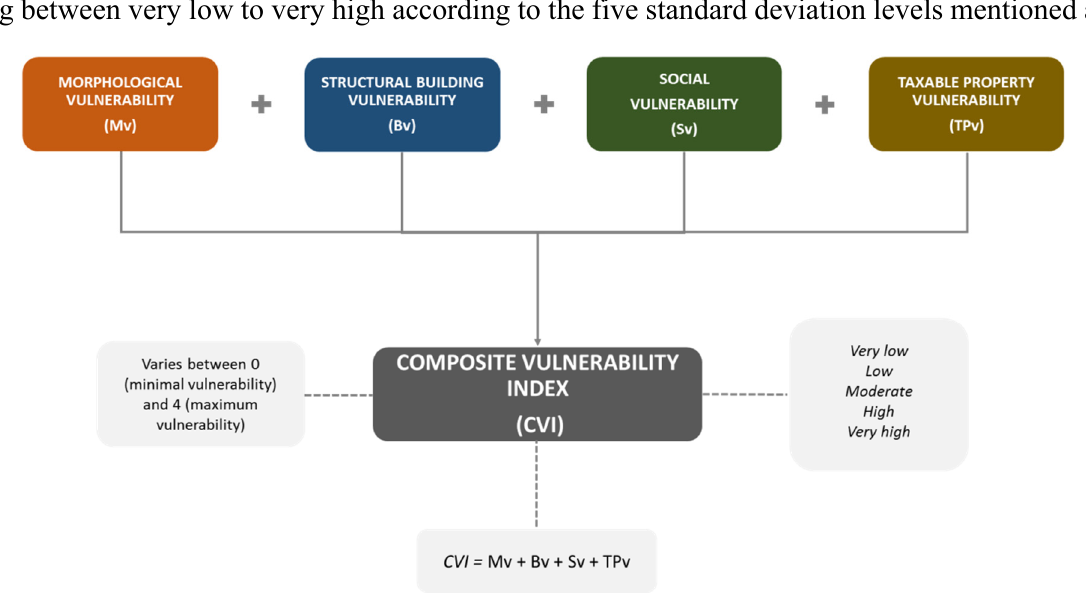
Figure 11. Graphical process of Composite Vulnerability Index